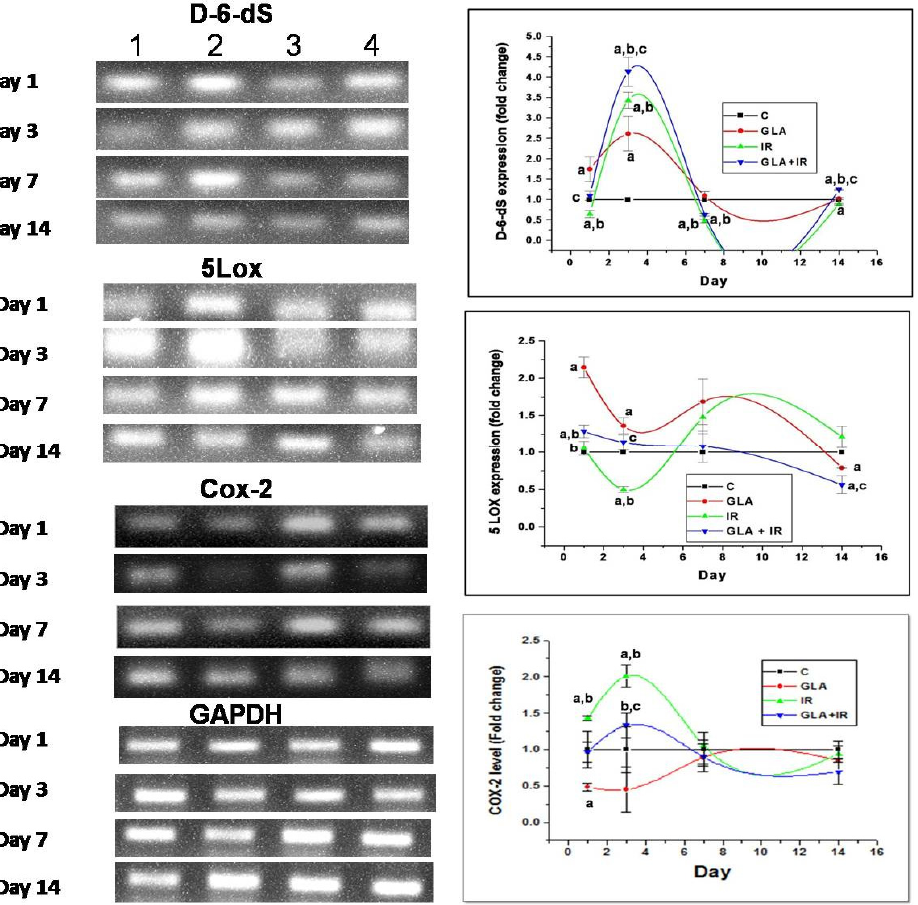
Figure 12. Effect of GLA and irradiation on genes associated with PUFA metabolism in duodenum tissue on day 1, day 3, day 7, and day 14. Values (n = 3) expressed as mean ± SEM. a , b , c Significant ( p < 0.01) when compared with control, GLA, and irradiation, respectively. 1, C; 2, GLA; 3, IR; and 4, GLA + IR. C, control; GLA, gamma-linolenic acid; IR, irradiation (7.5 Gy).